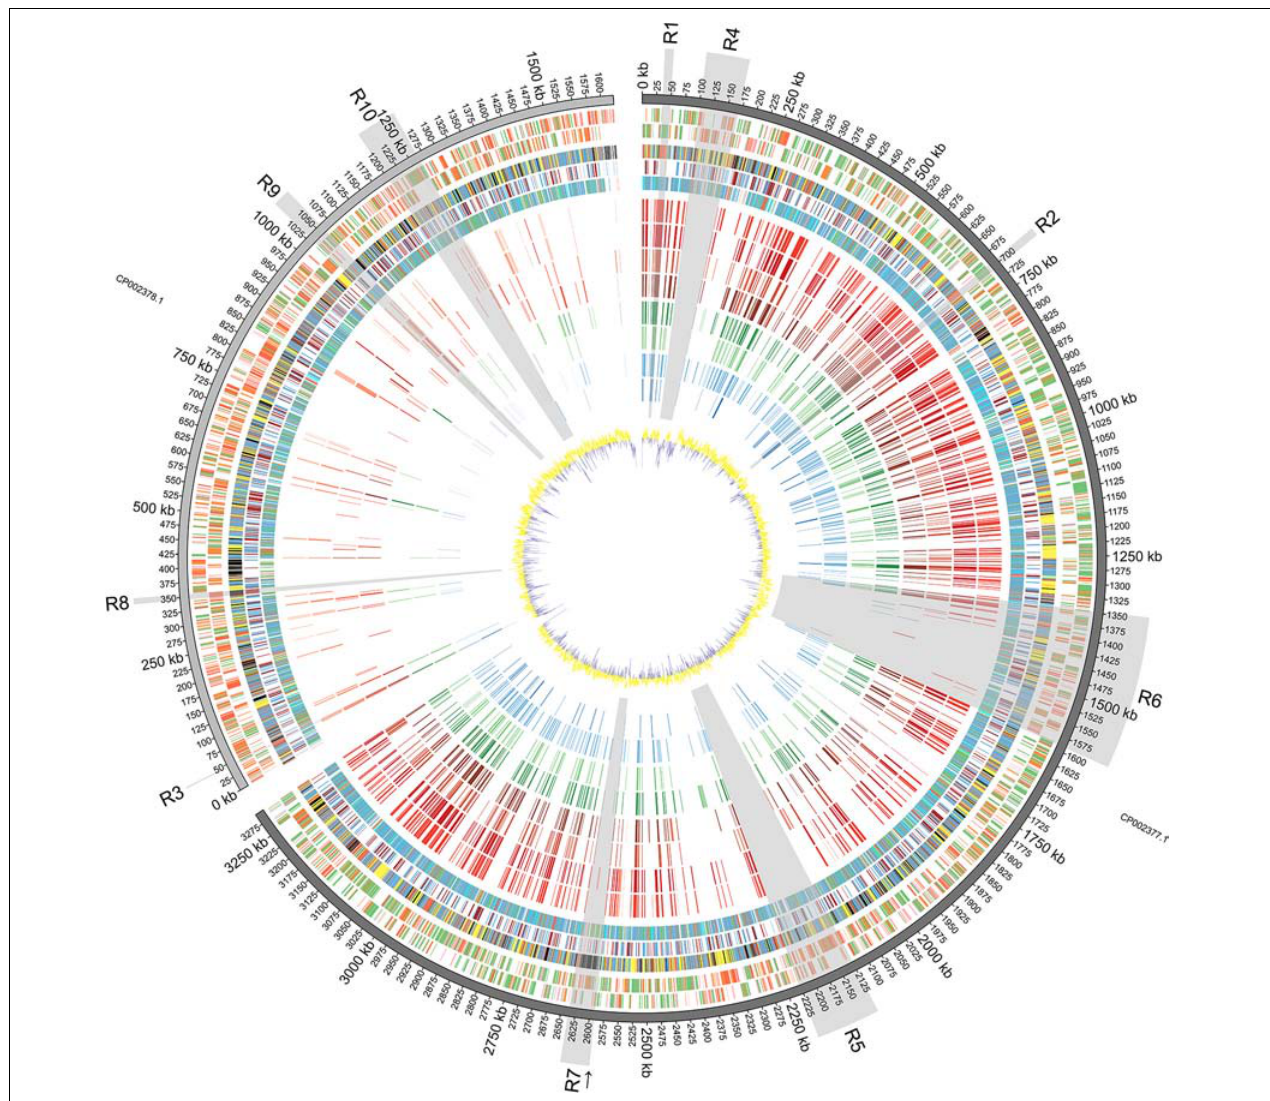
FIGURE 1 | Diagrammatic Representation of the Vibrio furnissii Genome: From outside to inside: Predicted ORFs on V. furnissii forward strand (track 1) and reverse strand (track 2). Green represents 100–80% amino acid identity; Orange, 80–60% identity and Red below 60% identity; COG classification (track 3; Information storage and processing: pink, Cellular processes and signaling: yellow, Metabolism: blue, Poorly characterized: Gray, No hits: black), TMH and SP prediction (track 4; Blue: THM, Light green: SP; Brown: THM+SP), representation of phylogenetic trees (track 5; Red: 3–10 species per leaf; Green: 11–100 species per leaf; Blue: 101–1000 species per leaf; Cyan: 1001 to END species per leaf), NUCMER comparison